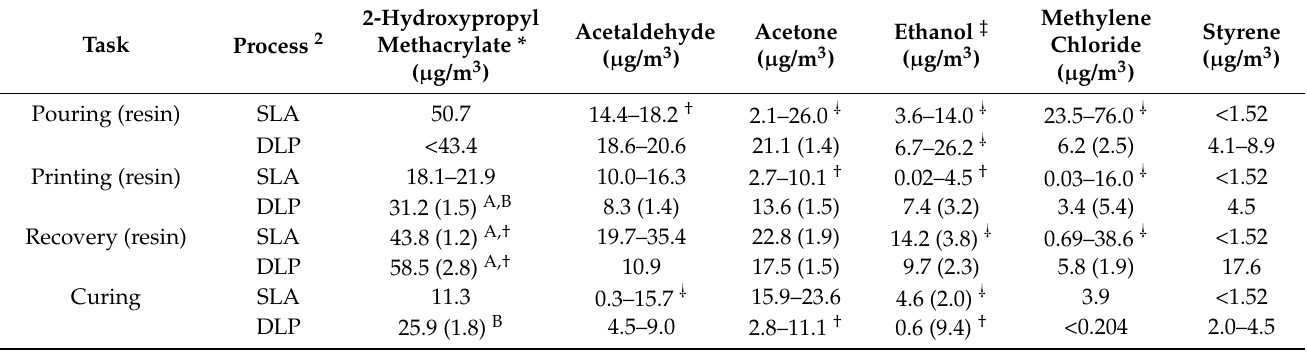
Table 4. Background-corrected airborne concentrations of organic gases for resin-associated tasks. Values are geometric mean and (geometric standard deviation) unless noted otherwise (n = 5 repli- cates) 1 .